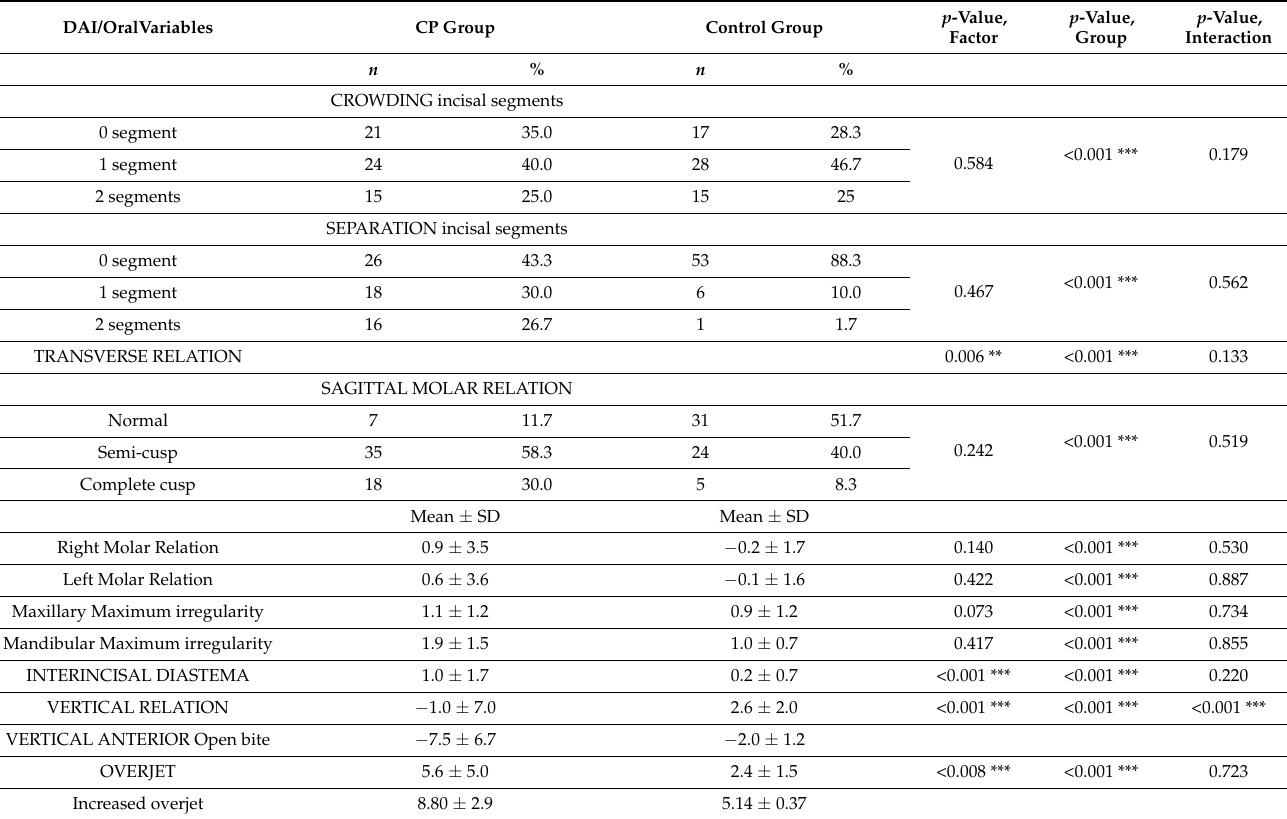
Table 5. Descriptive relationship between the DAI components and oral variables and the F-test results of the ANCOVA model for principal effects and the interaction of the relationship between the DAI score, oral variables and group (Cerebral Palsy [CP] and Control); p < 0.01 **; p < 0.001 ***. SD standard